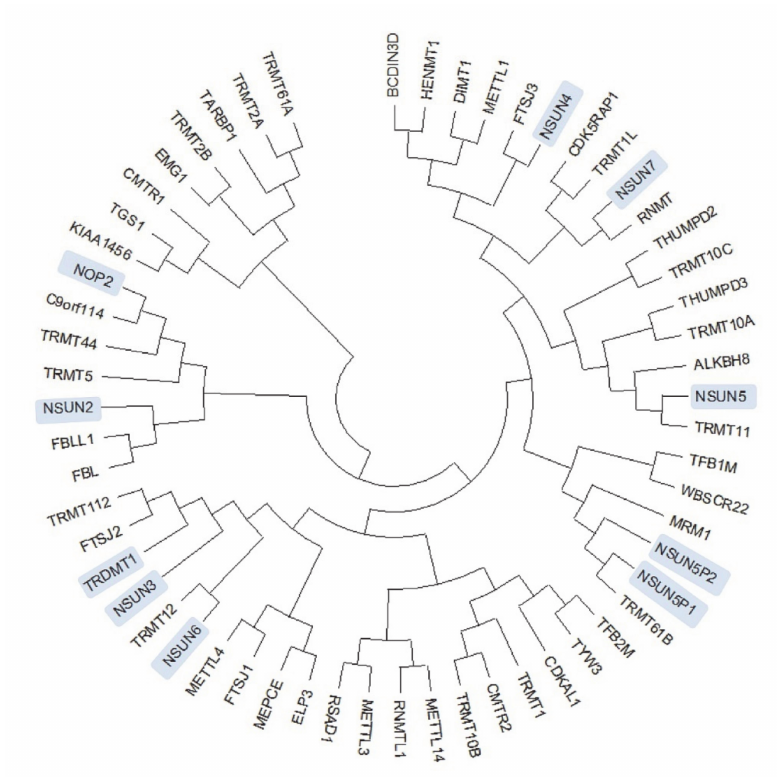
Figure 1. Phylogenetic analysis of RNA methyltransferases (RNMTs): Analysis was conducted using MEGA-X [29]. The sequences of 58 RNMTs were obtained from the ChromoHub database [30] and aligned, and an evolutionary phylogenetic tree was inferred by using the maximum likelihood method and Jones, Taylor & Thornton (JTT) matrix-based model [31], using default parameters. Members of the m5C RNMTs are highlighted in